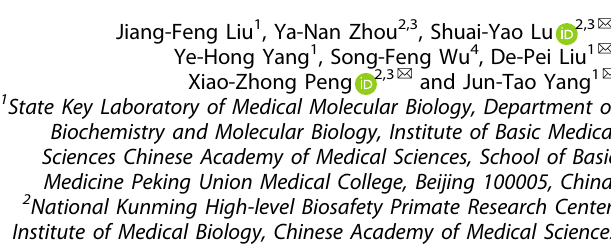
Fig. 1 Proteomic, phosphoproteomic, and bioinformatic analyses of rhesus macaques with COVID-19. a Brief work fl ow of this study. b KEGG enrichment analysis of differentially expressed proteins in the lung of control and virus-infected rhesus macaques. Red: upregulated. Blue: downregulated. c KEGG enrichment analysis of differentially expressed proteins in the liver of control and virus-infected rhesus macaques. Red: upregulated. Blue: downregulated. d , e Dominant pathways in the lung ( d ) and liver ( e ). Red boxes with black border: upregulated proteins in the infected tissue. Blue boxes with black border: downregulated proteins in the infected tissue. Pink boxes with pink border: kinases predicted to be activated in the infected tissue. White boxes: proteins in the pathway but not in the differentially expressed proteins. f Correspondence between the predicted kinases and FDA-approved drugs in DrugBank. Red marked drugs were predicted to work in both the lung and the liver. Red circles represent predicted activated kinases in the lung. Red and blue squares represent predicted activated and inhibited kinases in the liver,